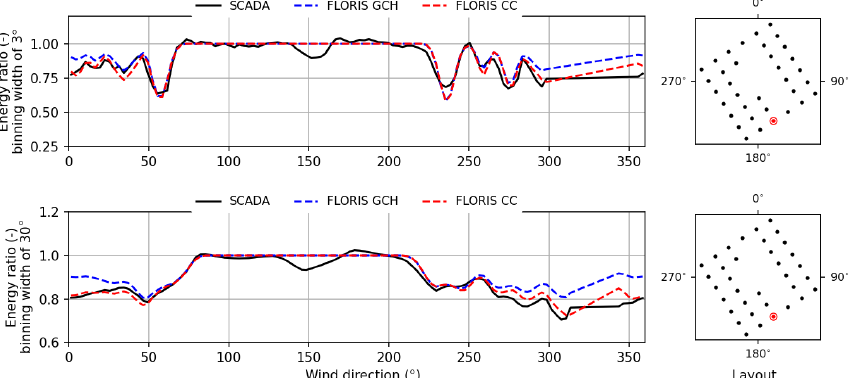
Figure 12. Energy ratio versus wind direction for Turbine 14, located in the south of the Westermost Rough wind farm. The reference turbines to which the energy ratio is normalized are the turbines that are both operating in freestream flow and within a 5km radius of Turbine 14. The reference wind direction is determined by the nacelle headings from turbines directly neighboring Turbine